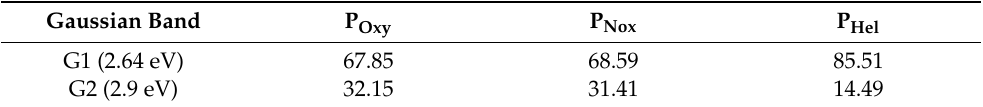
Table 1. Normalized areas of Gaussian sub-bands (in %) composing the PL spectra of the three Ce- doped preforms under excitation at 320 nm.